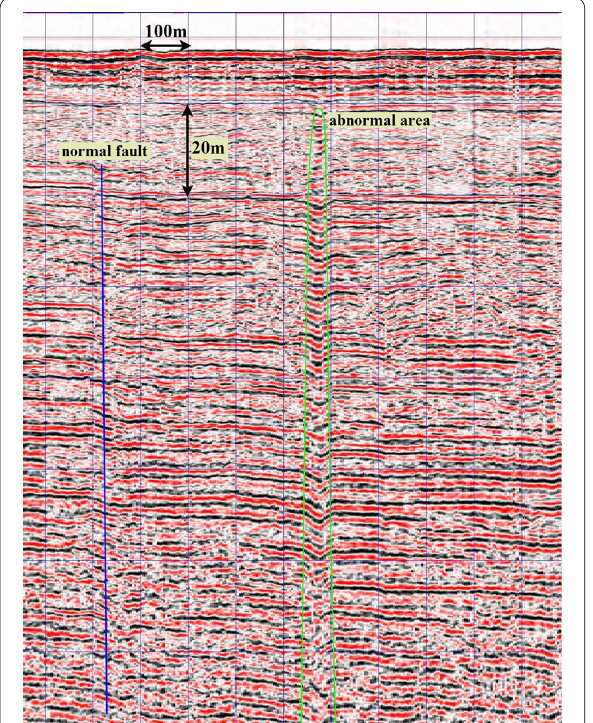
Fig. 7 Acoustic profile 2 in the survey area, and the seismic attribute is amplitude;